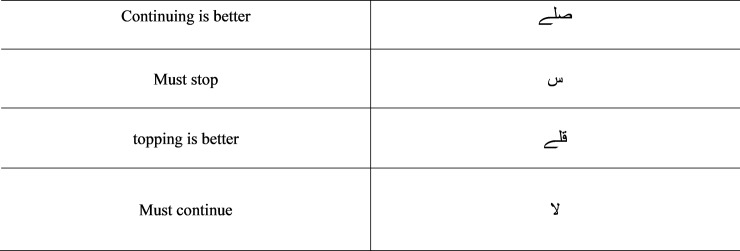
Tajweed symbols.